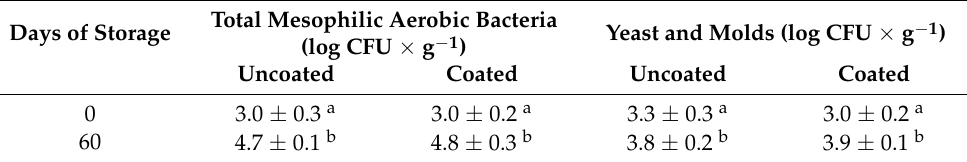
Table 4. Count of mesophilic aerobic bacteria and molds/yeasts on uncoated and coated Paipa cheese samples at the initial time and day 60 of storage. Days of